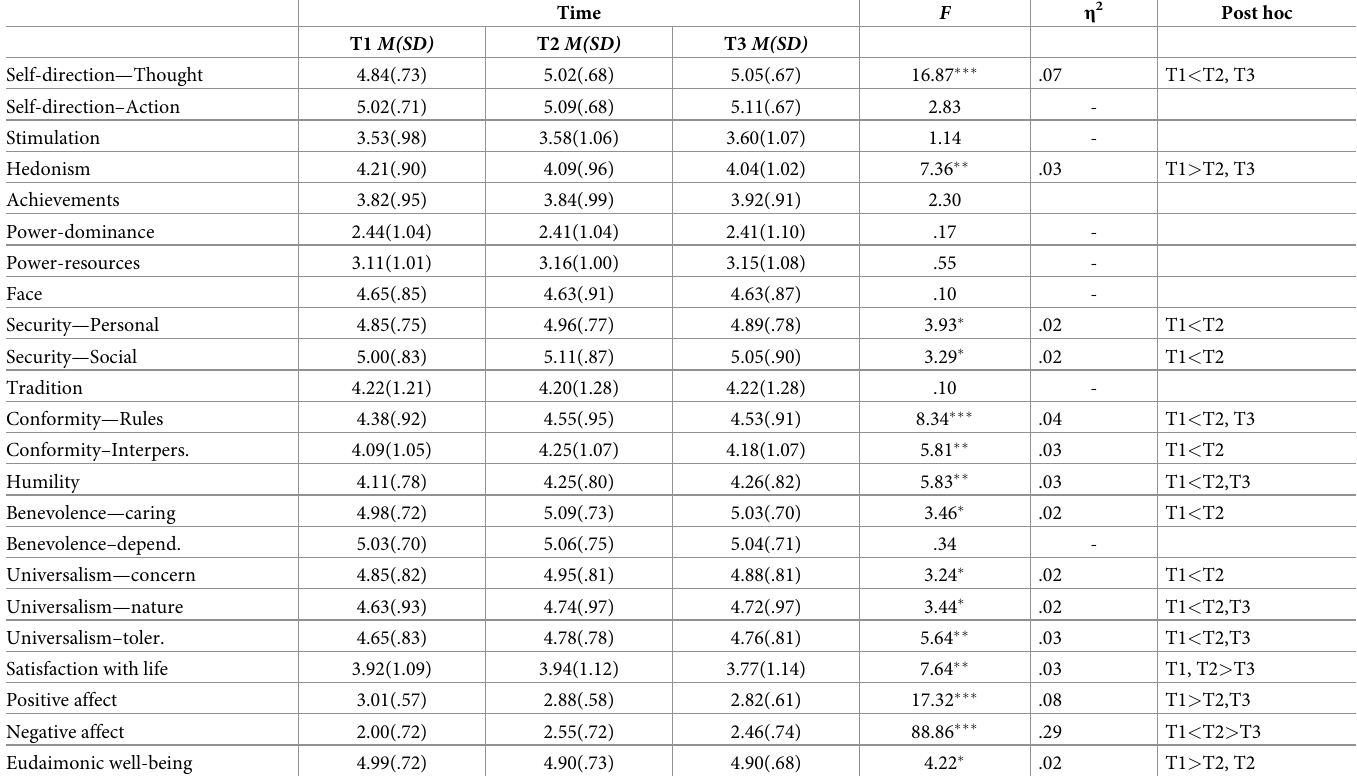
Table 1. Differences in values and well-being levels before and during the COVID-19